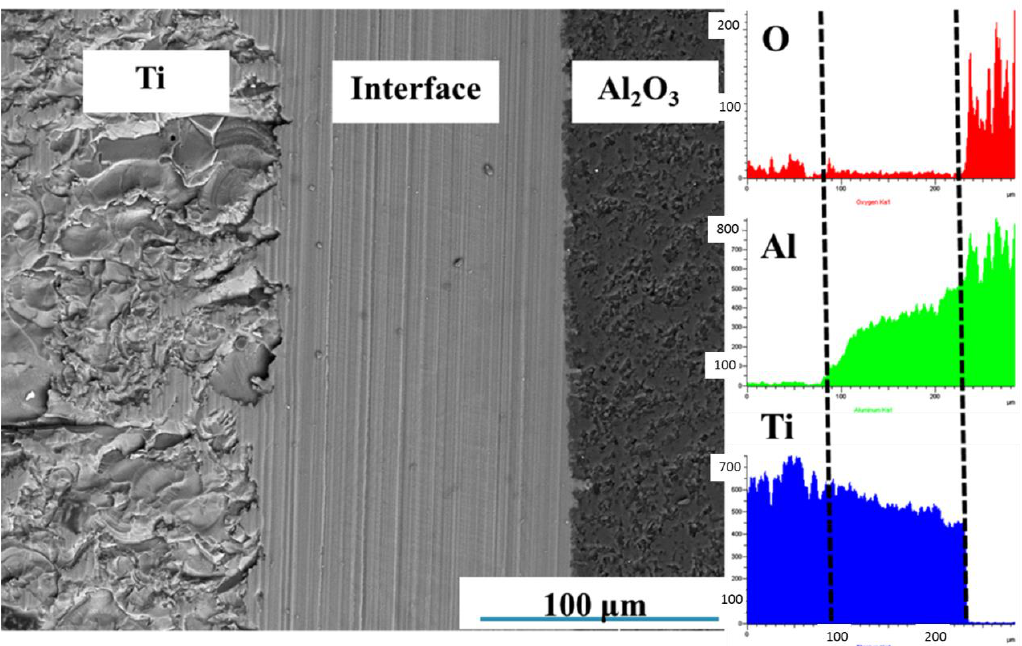
Figure 9. SEM images and line scanning analysis of interface at 1450 °C with holding time of 3 h.